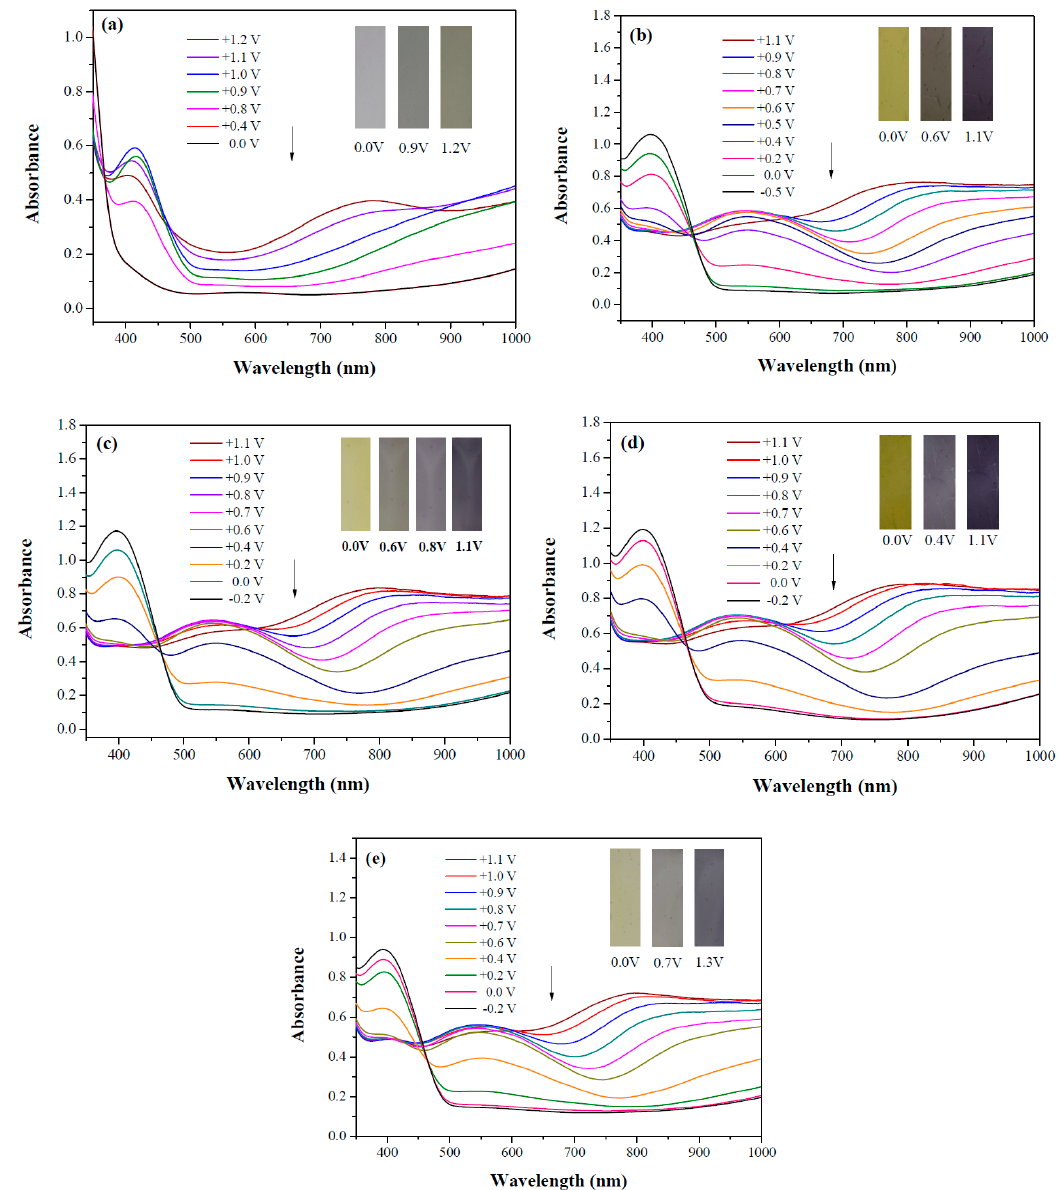
Figure 5. UV-Visible spectra of ( a ) PdCz; ( b ) P(dCz2- co -dTC1); ( c ) P(dCz2- co -dTC2); ( d ) P(dCz1- co -dTC2) and ( e ) PdTC electrodes on ITO in ACN / DCM (1:1, by volume) solution containing 0.2 M LiClO 4 . PdCz displayed multichromic behaviors with a light gray color in its neutral state (0.0 V), an iron grey color (0.9 V) and a dark gray color (1.2 V) during stepwise oxidation. The colors of PdTC electrode were light yellowish-gray, light gray, and iron grey at 0.0, 0.7, and 1.3 V, respectively. The dCz- and dTC-containing copolymer electrodes displayed di ff erent multichromic behaviors with PdCz and PdTC electrodes. P(dCz2- co -dTC1) film was yellowish green, gray, and purplish grey at 0.0, 0.6, and 1.1 V, respectively, whereas P(dCz2- co -dTC2) film was yellowish green, greenish gray, gray, and purplish gray at 0.0, 0.6, 0.8, and 1.1 V, respectively, and P(dCz1- co -dTC2) film was yellow, gray, and dark purplish-grey at 0.0, 0.4, and 1.1 V, respectively. The colorimetric values ( L *, a *, and b *), CIE (Commission Internationale de I’Eclairage) chromaticity values ( x , y ) and diagrams of the five polymer films at various potentials are listed in Table 2.